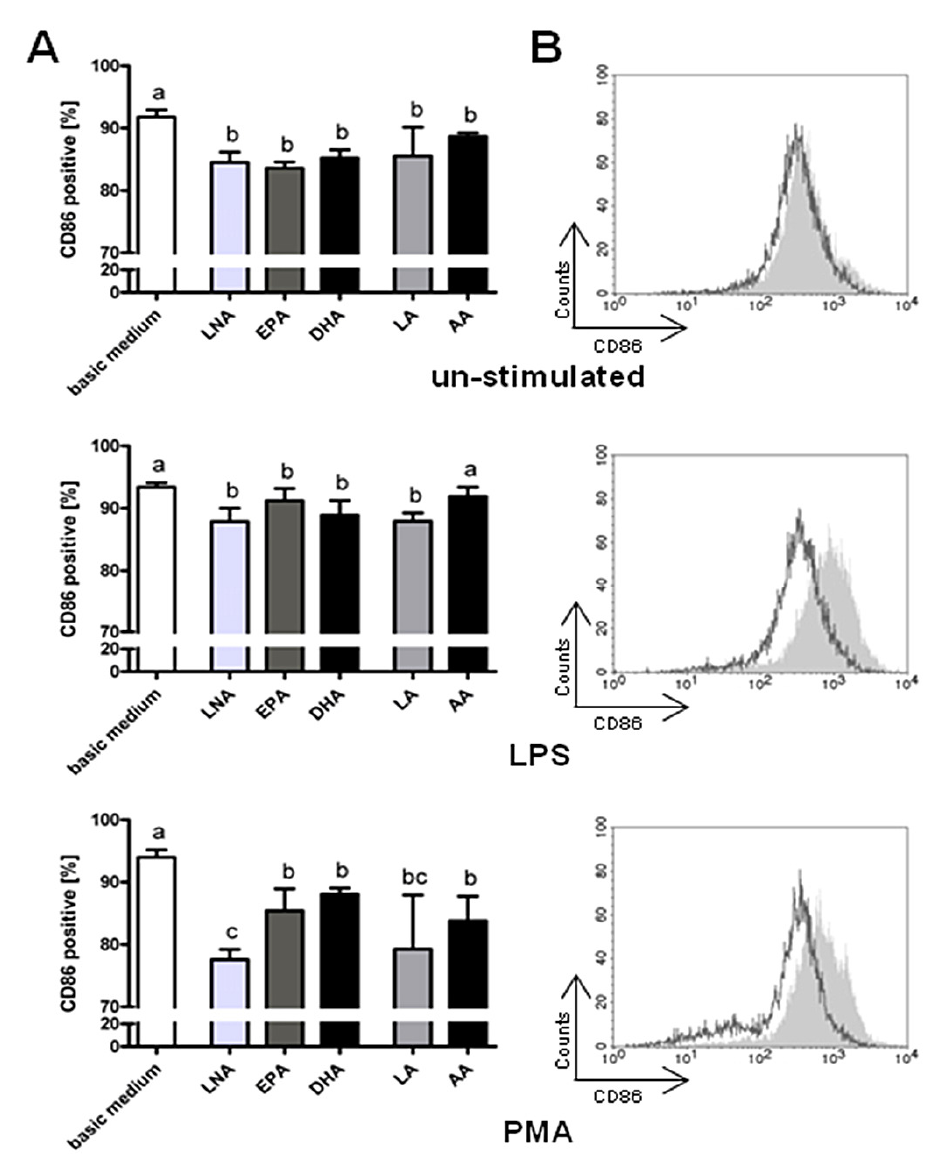
Figure 8. Expression of the surface molecule CD86 by RAW264.7 macrophages cultured in basic medium as well as in medium supplemented with 15 µmol/L alpha-linolenic acid (LNA), eicosapentaenoic acid (EPA), docosahexaenoic acid (DHA), linoleic acid (LA) or arachidonic acid (AA) after 24 h of stimulation with LPS, PMA, P. aeruginosa ATCC 10145 and R. equi ATCC 33701 respectively. ( A ) Percentage of CD86 positive cells. Data are mean ± SD ( n = 6). Bars denoted by different letters are significantly different; ( B ) Histograms of surface expression levels of CD86. The grey-shaded histograms correspond to RAW264.7 cultured in basic medium, and empty histograms (dark grey line) correspond to RAW264.7 cultured in LNA supplemented medium. Histograms are representative of one of six